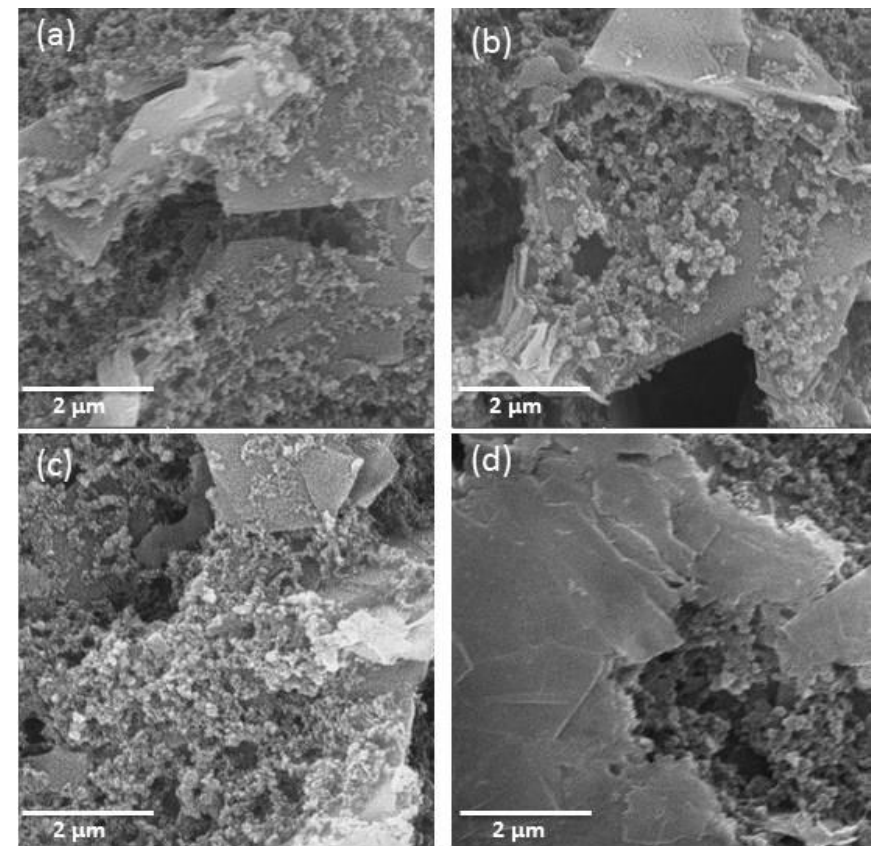
Figure 2. Scanning electron microscope (SEM) images of bare-screen printed carbon electrode (SPCE) ( a ) MWNT-SPCE ( b ), aptamer immobilized MWCNT-SPCE ( c ) mucine–aptamer MWCNT-SPCE; and ( d ) Scale bar: 2.0 μm ( a – d ).